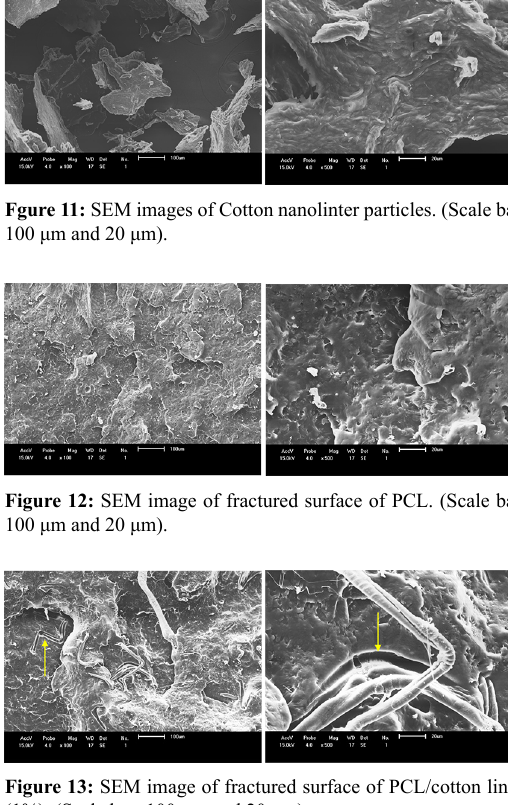
Figure 13: SEM image of fractured surface of PCL/cotton linter (1%). (Scale bar: 100 μm and 20